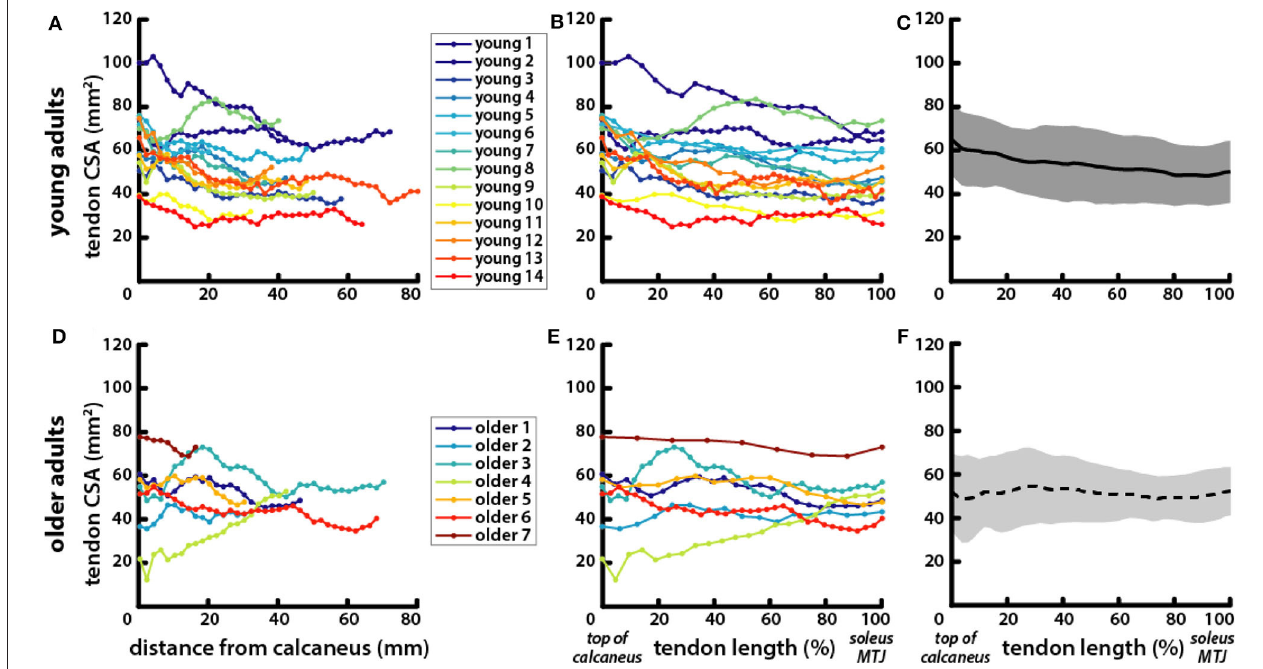
FIGURE 4 | Tendons exhibited greater variation in length and CSA within age groups than between young and older adults. Achilles tendon CSA was measured in axial MR images of (A) young and (D) older adults from the most proximal image where the calcaneus was visible to the most distal image where the soleus was visible. CSA locations are reported as their distance from the calcaneus in the proximal–distal direction. To account for variations in free tendon length, CSA locations were normalized to length for (B) young and (E) older adults with the top of the calcaneus being the most distal point at 0% and the soleus MTJ the most proximal point at 100%. Average tendon CSA is plotted with normalized tendon length in (C) young (solid line, gray shading for standard deviation) and (F) older (dotted line, light gray shading)